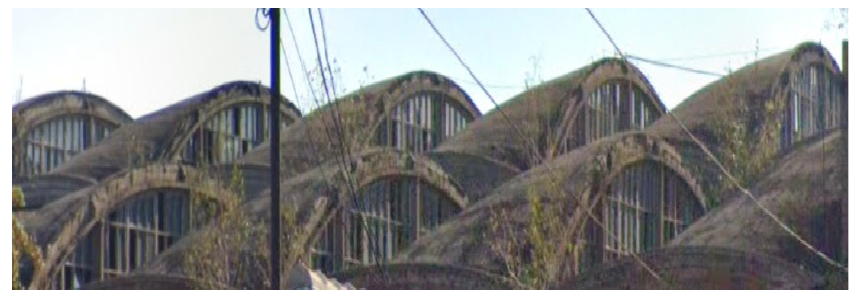
Figure 21. Close ‐ up of the array of the conoids still standing after 64 years without maintenance.